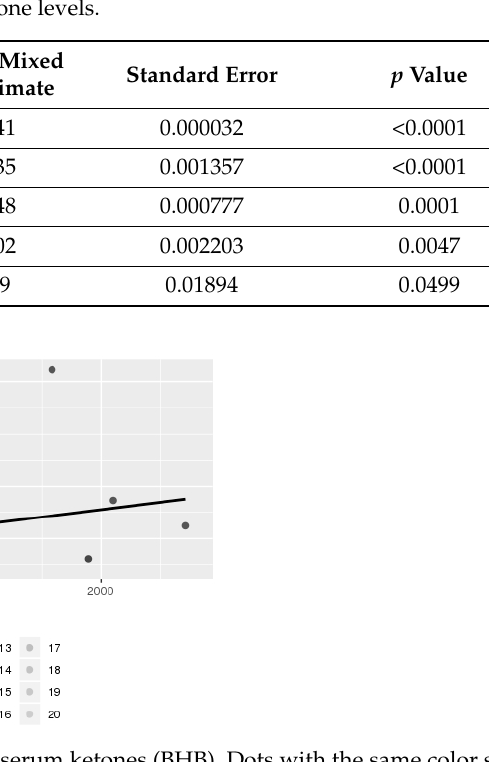
Figure 2. Scatter plot for breath TMA vs. serum ketones (BHB). Dots with the same color shade belong to the same patient.